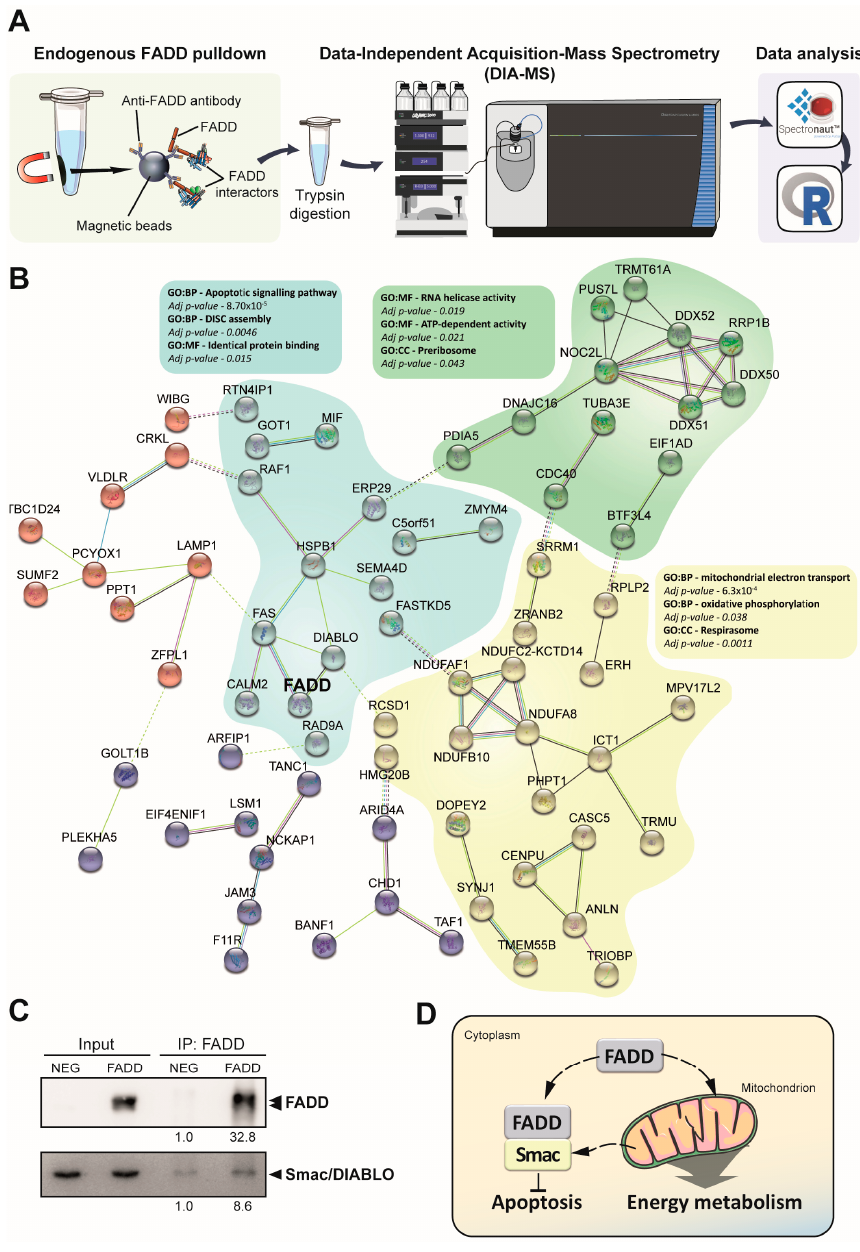
Figure 5. Interactome analysis using DIA-MS confirms FADD participation in energy metabolism processes. ( A ) Workflow of co-Immunoprecipitation-Mass Spectrometry. Endogenous FADD protein was co-immunoprecipitated from FADD-expressing (FADD) and FADD-deficient (NEG) JURKAT cell lines using magnetic beads. Samples were trypsin-digested and injected into the mass spectrometer for data-independence acquisition. Finally, the raw data were analyzed with Spectronaut software and R. ( B ) STRING interaction map of significant proteins that interact with FADD in JURKAT cells compared to JURKAT-deficient FADD (FADD NEG). Proteins were clustered based on K-means into five clusters. The functional enrichment analysis and adjusted p -value (adj. p -value) are shown for the three main clusters. ( C ) Validation of DIABLO–FADD interaction. The input and immunoprecipitated (IP) fractions were separated by SDS-PAGE and blotted with antibodies against anti-FADD and -DIABLO. The densitometry values are shown below. ( D ) Schematic representation to show interactions of FADD with proteins involved in different biological processes. Under non- apoptotic conditions, FADD interacts with DIABLO/Smac, which hampers FADD function inducing apoptosis. FADD also interacts with several proteins involved in the energy